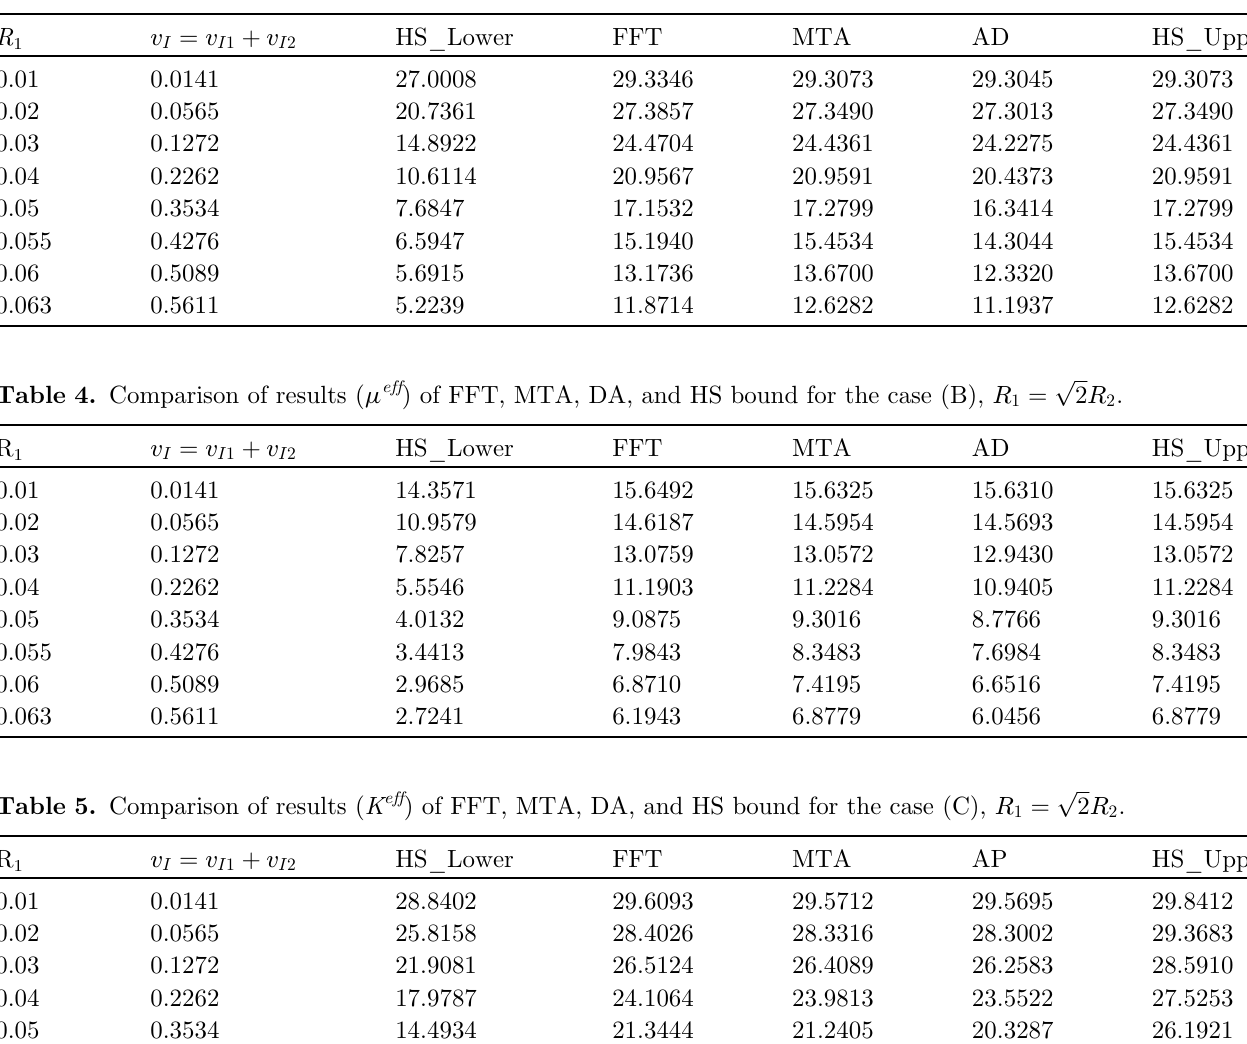
Table 3. Comparison of results ( K eff ) of FFT, MTA, DA, and HS bounds for the case (B), R 1 ¼ 2